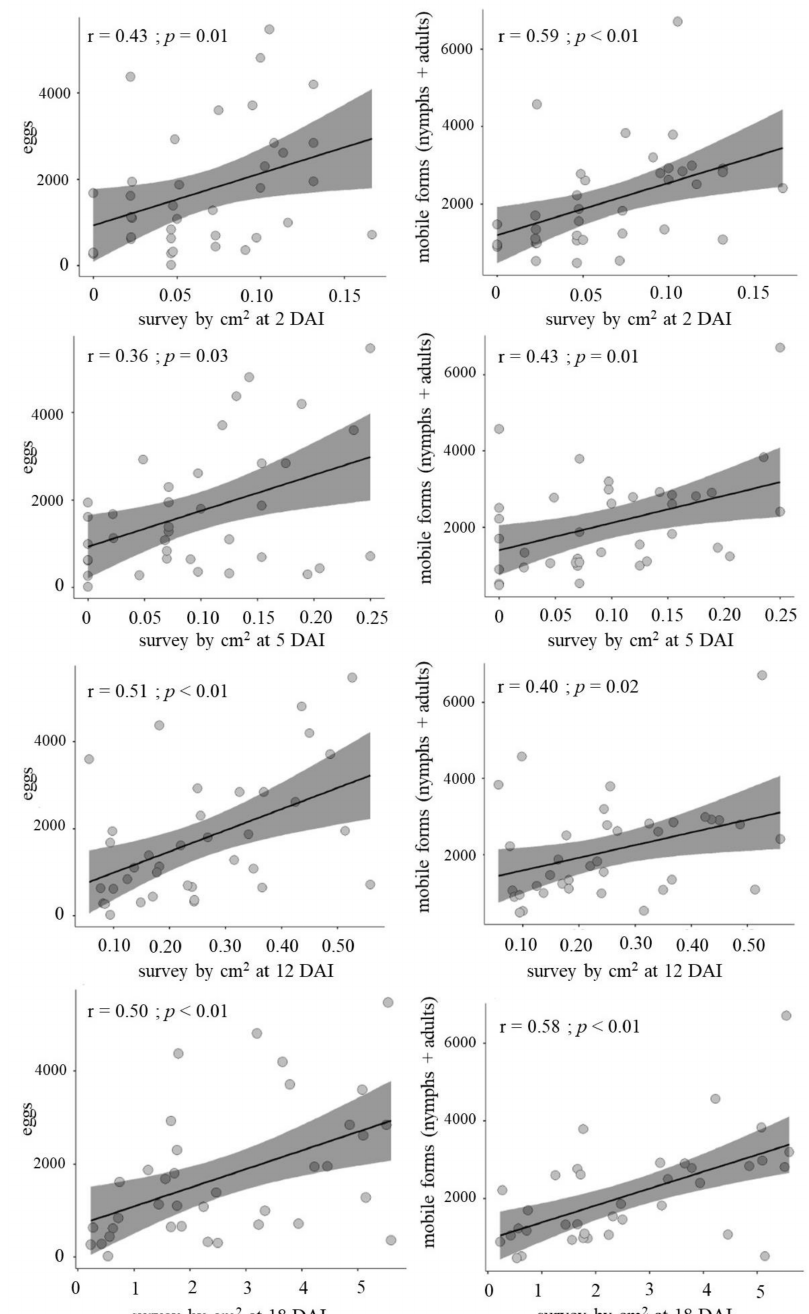
Figure 2. Spearman coefficient (r) of the number of broad mites ( Polyphagotarsonemus latus ) on common bean leaves 15 days after infestation assessed through destructive assessment vs. number of mobile forms assessed using hand magnifying lenses. p -Values indicate correlation significance. Londrina-PR, Brazil,